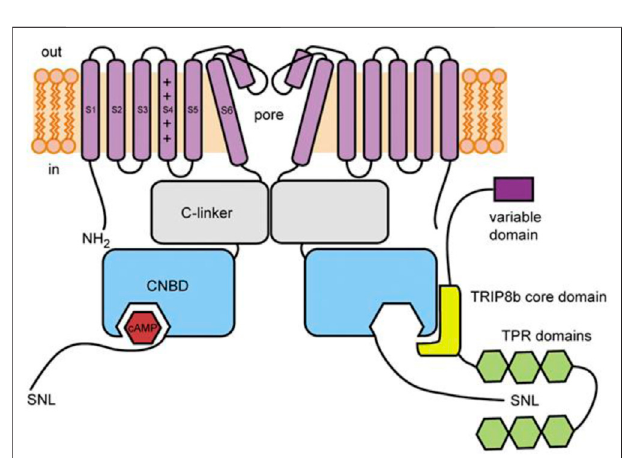
FIGURE2| SchematicillustrationofTRIP8banditsinteractionwithHCN channels. The core domain of TRIP8b ( yellow ) antagonizes cAMP binding to the CNBD of HCN channels ( blue ). The TRP domains ( green ) interact with the SNL motif in the distal C-terminus to regulate HCN channel expression. From DeBerg et al.,